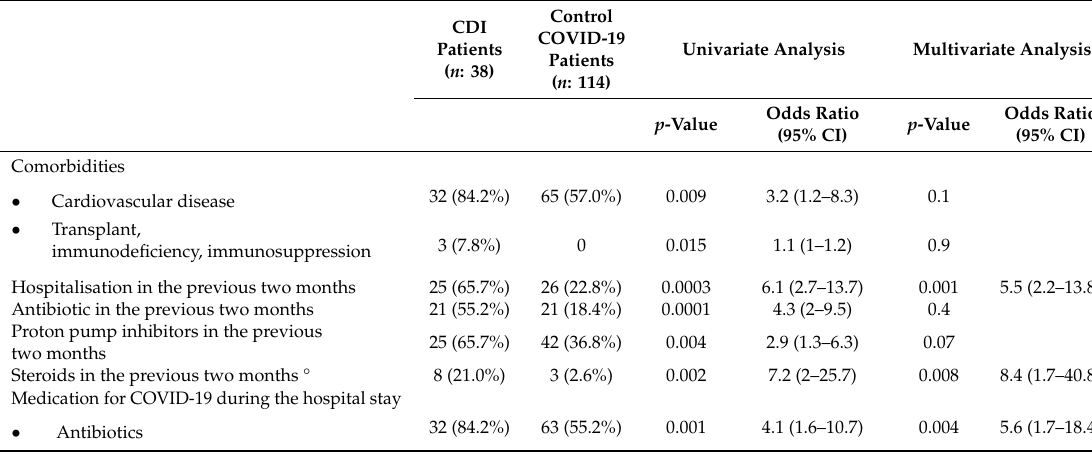
Table 4. Factors associated with the likelihood of CDI during COVID-19 infection. Logistic regression analysis. CI: confidence